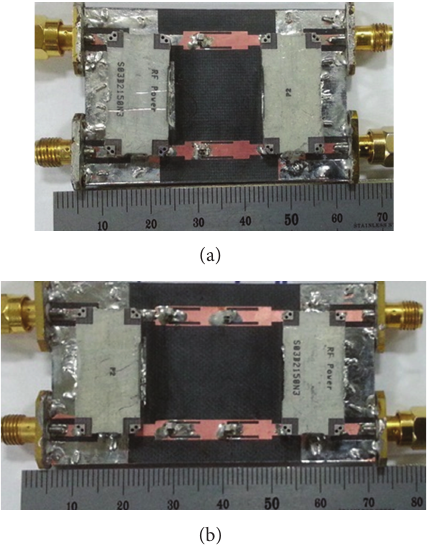
Figure 7: Photographs of fabricated circuits: (a) single-stage and (b) cascaded two-stage